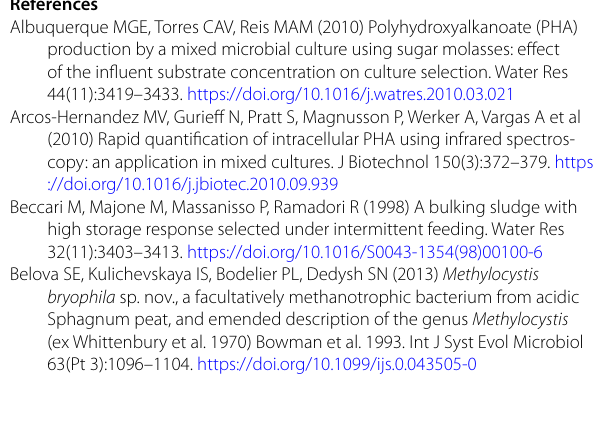
Additional file 1: Table S1. Phylogenetic classification of the 16S rRNA gene sequences (relative abundance > 1%) in methanotrophic–hetero- trophic